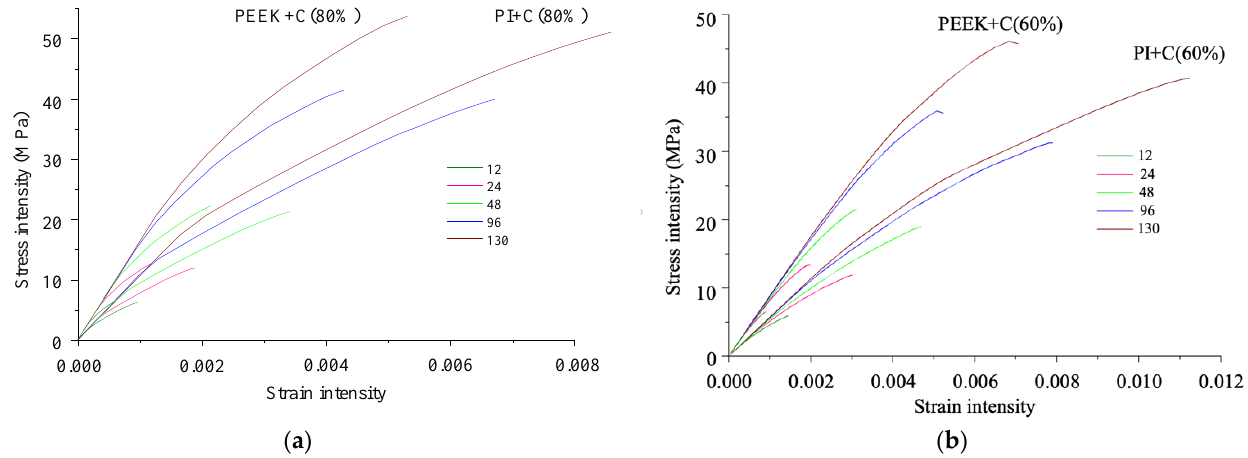
Figure 16. Stress vs. strain intensities of the PEEK- and PI-based composites under tension along the y -axis (across CF) with changing in the number of contacting points between the polymer and CF: the CF/polymer ratios of 80/20 ( a ) and 60/40 vol. % ( b ).